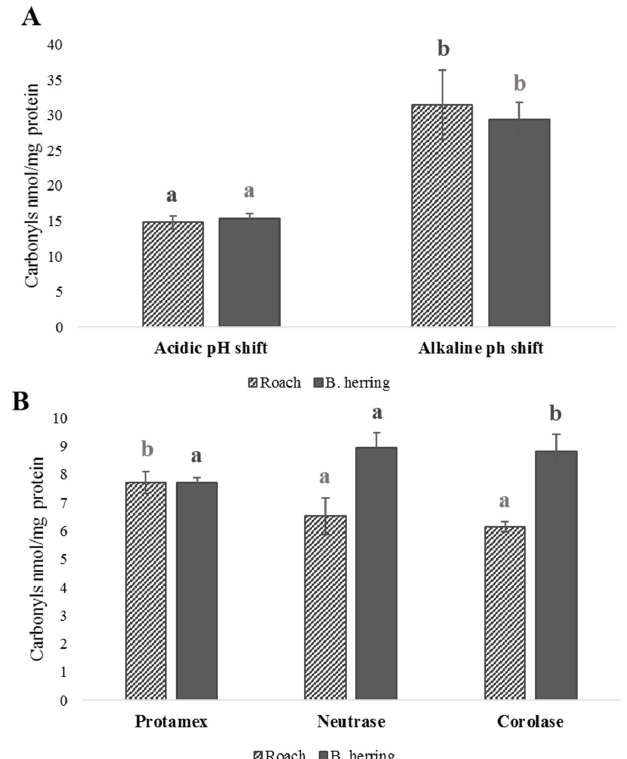
Figure 2. Protein carbonyls (nmol/mg protein) in protein isolates produced using pH shift ( A ), quantified using the original carbonyl method [40], and in enzymatically produced hydrolysates ( B ), analyzed using a modified method by Mesquita et al. [41]. Different letters within the same raw material indicate a statistically significant difference ( p < 0.05).